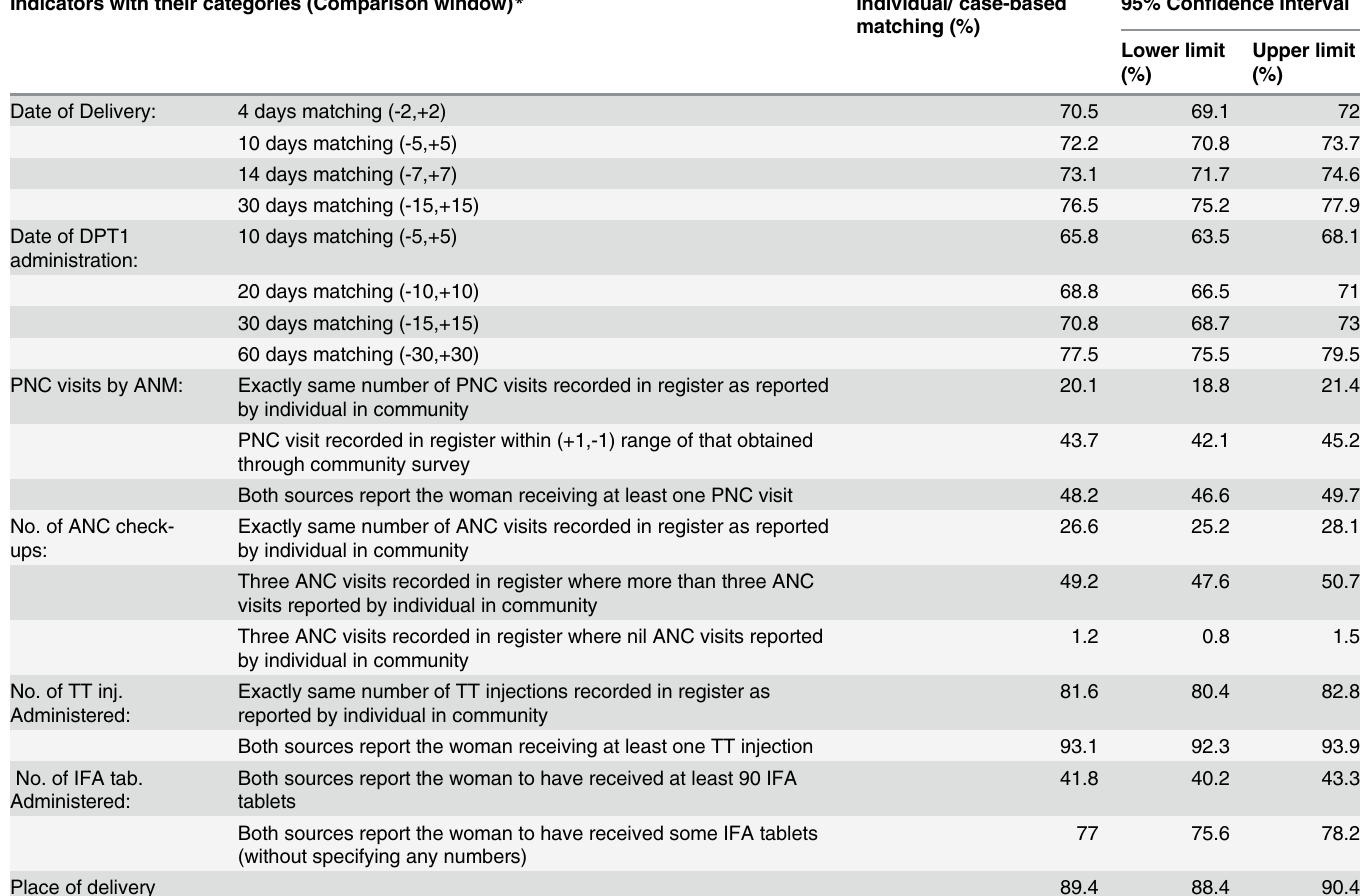
Table 3. Quality of health management information system in Haryana state, India. Indicators with their categories (Comparison window)